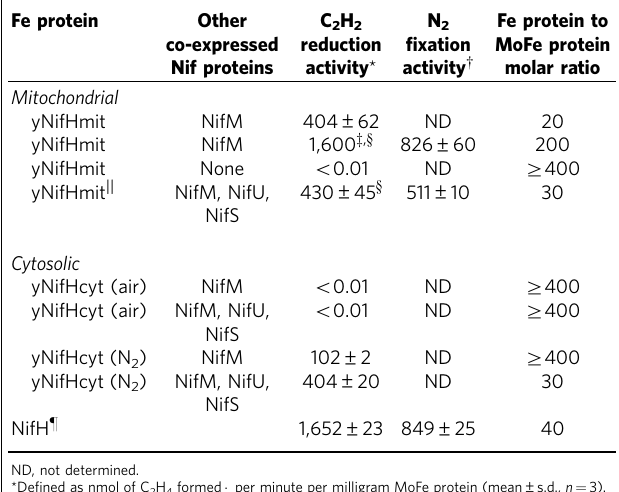
Table 1 | MoFe protein activity supported by yNifHmit and yNifHcyt purified